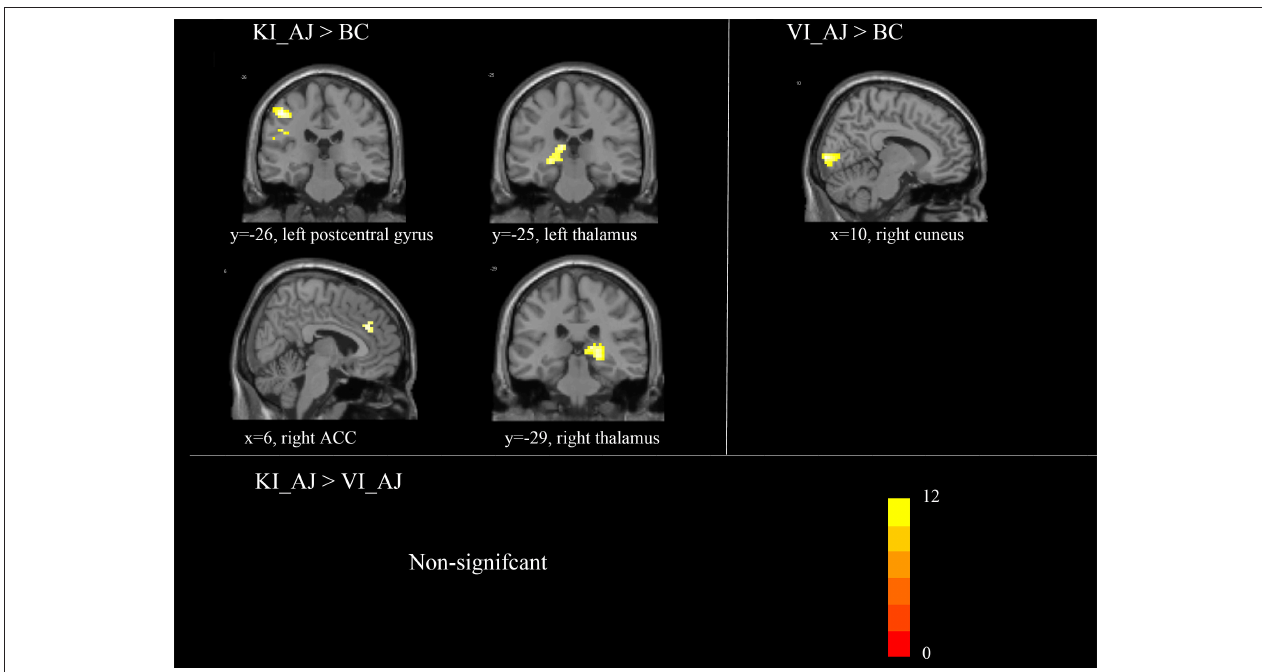
FIGURE 3 | Brain activated during aesthetic judgment for the contrast kinesthetic/visual automatic imagery. T-scores are rendered in colors ranging from 0 (red) to positive (yellow) as indicated by the accompanying colored